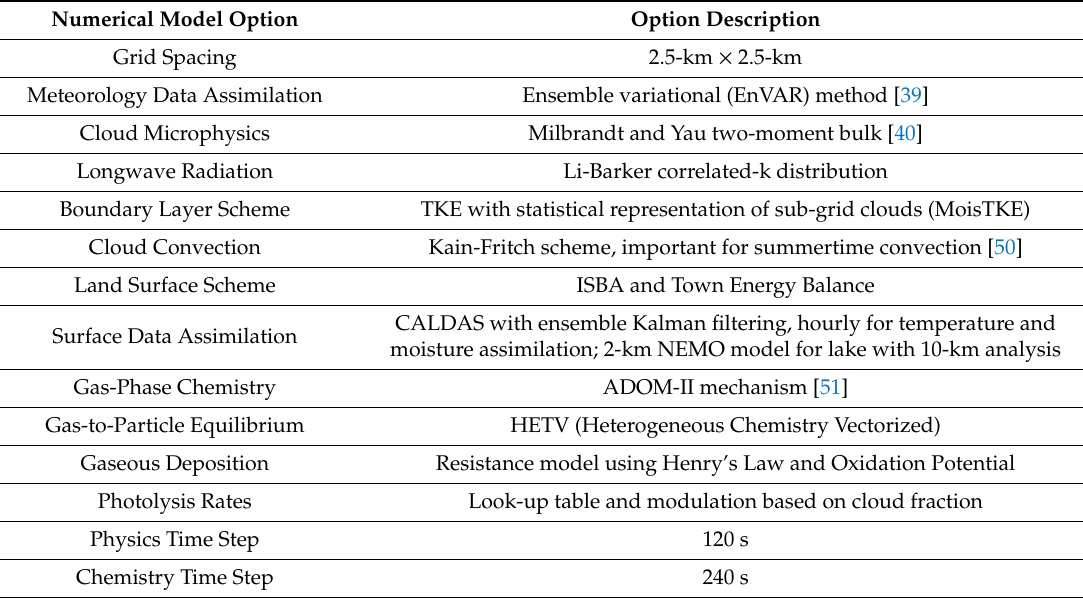
Figure 4. Schematic of processes in the GEM-MACH-TEB model. The GEM model (version 4.8.3-LTS.13) provides the central framework for the model system. Emissions and geophysical fields are input to the GEM model and surface and meteorological data are assimilated into the GEM model. The chemistry is called within the GEM code. Table 1. High-Resolution GEM-MACH-TEB model configuration and settings used for this study.